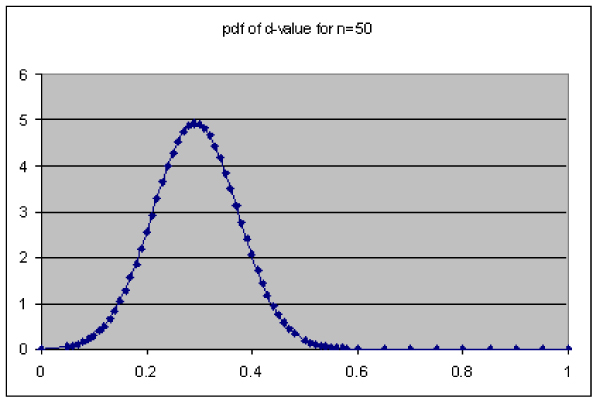
Asymptotic density function of d-value for a balance study with equal variance of one.